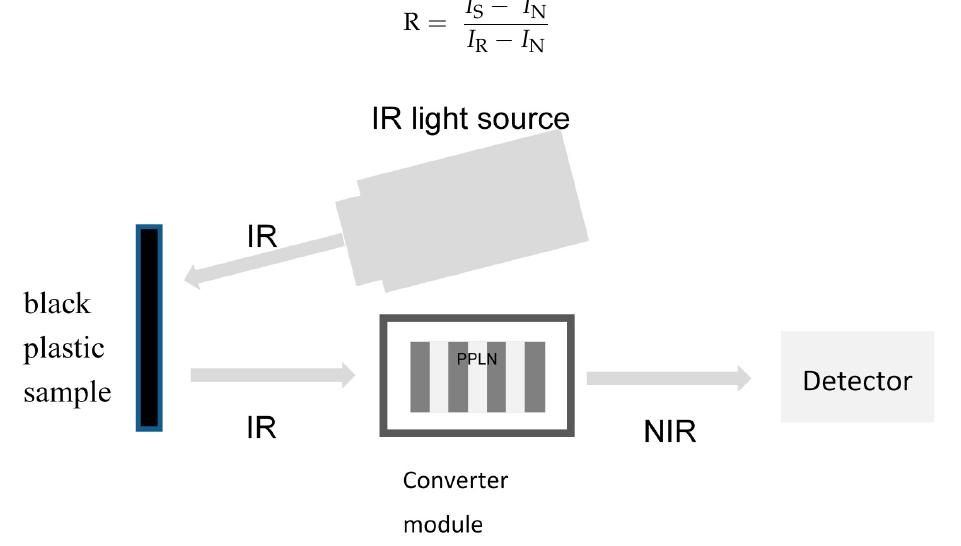
Figure 2. Schematic drawing of the measuring setup for the measurement of black plastics in reflection with the photon up conversion set-up.